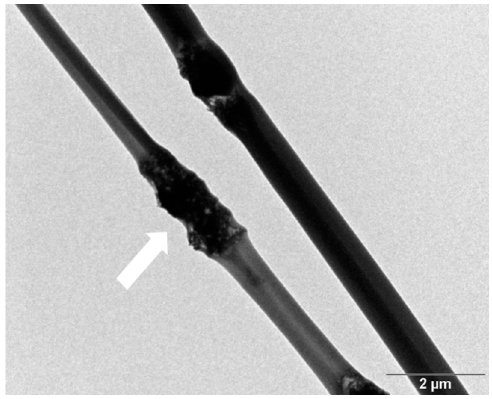
Figure 5. TEM micrograph of the PLA/15%nHA-3%GO nanocomposite fibrous mat. Fillers of PLA/15%nHA-3%GO fiber are indicated by an arrow.